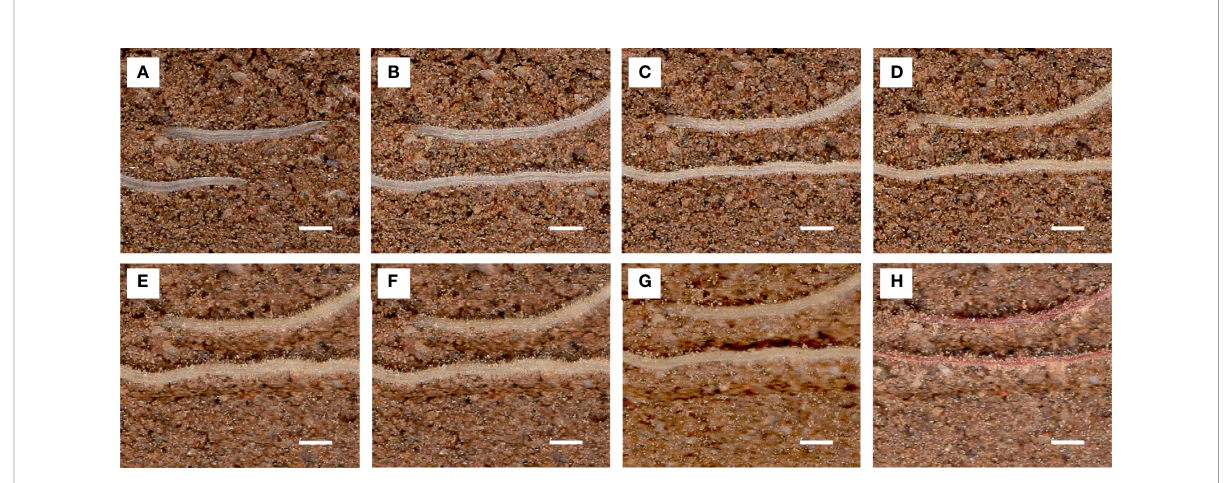
FIGURE 11 Images of the same root area at different time points used to calculate root lifespan. Scale bar, 1 mm. Root pictures for different days: (A) 1 d, (B) 10 d, (C) 20 d, (D) 30 d, (E) 40 d, (F) 50 d, (G) 60 d, and (H) 70 d (dead